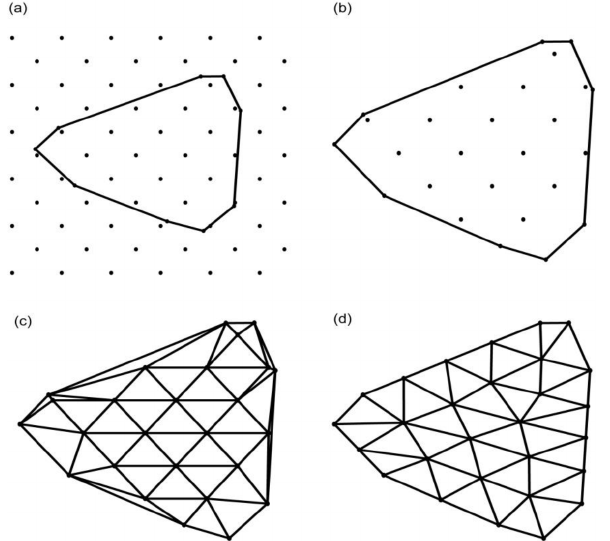
Figure 4. (a) Two sets of nodes for initialization – one set is gener- ated using a mesh background with a desired size which is usually slightly larger than the region of the GNSS signals at all time and the other set is at all the vertices of the polygon (all black points); (b) initial nodes; (c) topology formed using Delaunay triangulation; (d) nodes with equidistance adjusted based on the force displace- ment algorithm.